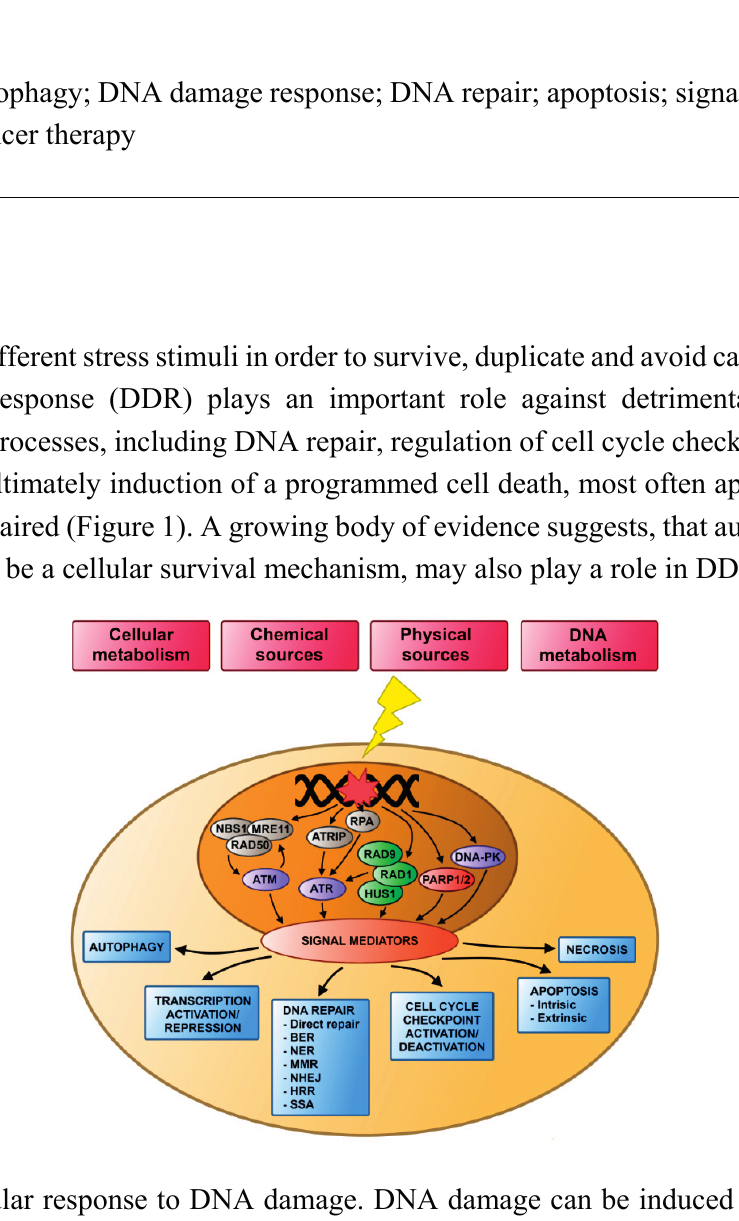
Figure 1. Cellular response to DNA damage. DNA damage can be induced by exogenous chemical and physical factors, or by endogenous influences following from cellular and DNA metabolism. The induction of DNA damage triggers the DNA damage response (DDR). Three proteins from the phosphatidylinositol 3-kinase-like protein kinases (PIKKs) family plays a major role in DDR: ataxia telangiectasia mutated (ATM), DNA protein kinase (DNA-PK) and ataxia telangiectasia and Rad3 related (ATR), two proteins of the poly(ADP-ribose) polymerase (PARP) family: PARP1 and PARP2, and heterotrimeric complex of Rad9, Rad1 and Hus1 (9–1–1 complex). These proteins are activated by either DNA damage itself or by other proteins. After ATM, ATR, DNA-PK, PARP1/2 or 9–1–1 complexes are activated, they transfer signals via signal mediators to regulate many cellular processes, including DNA repair, cell checkpoint activation or deactivation, activation or silencing of transcription, apoptosis and